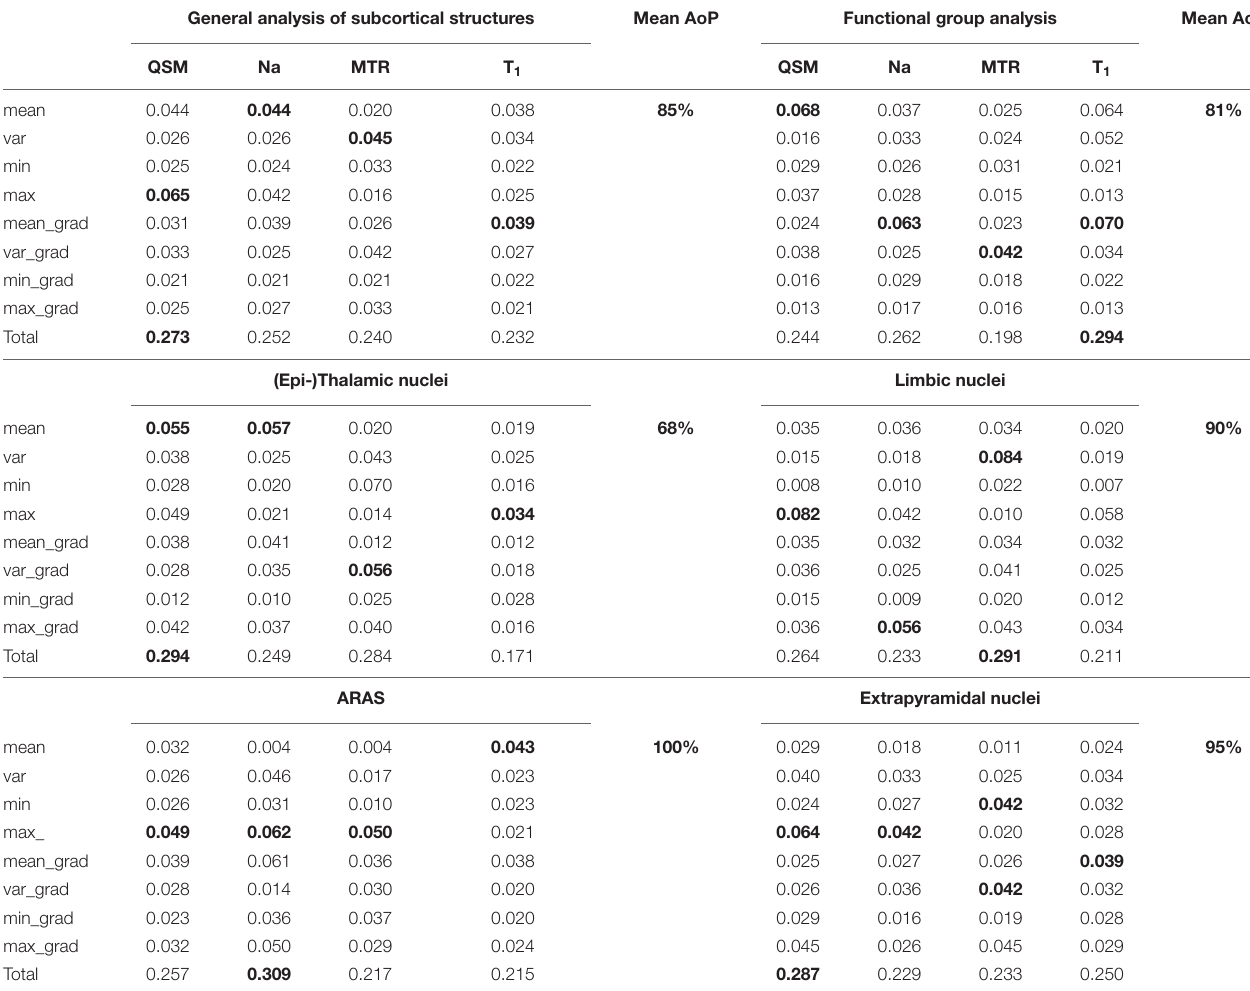
TABLE 5 | Feature importance for each contrast and parameter. General analysis of subcortical